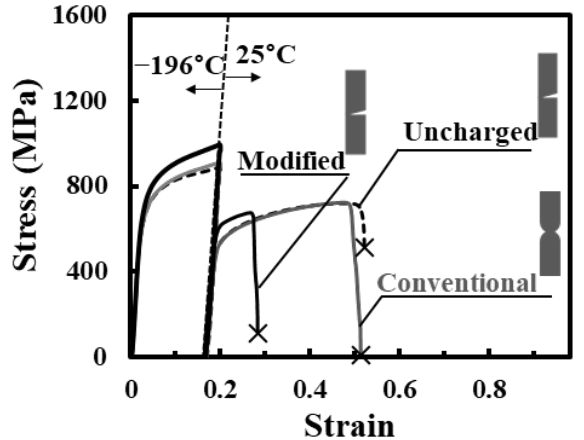
Figure 8. Tensile stress–strain curves of uncharged and charged specimens subjected to tensile straining to 0.2 and unloading at −196 °C followed by tensile test until fracture at 25 °C. The schematic diagrams show the fracture mode of the specimen.